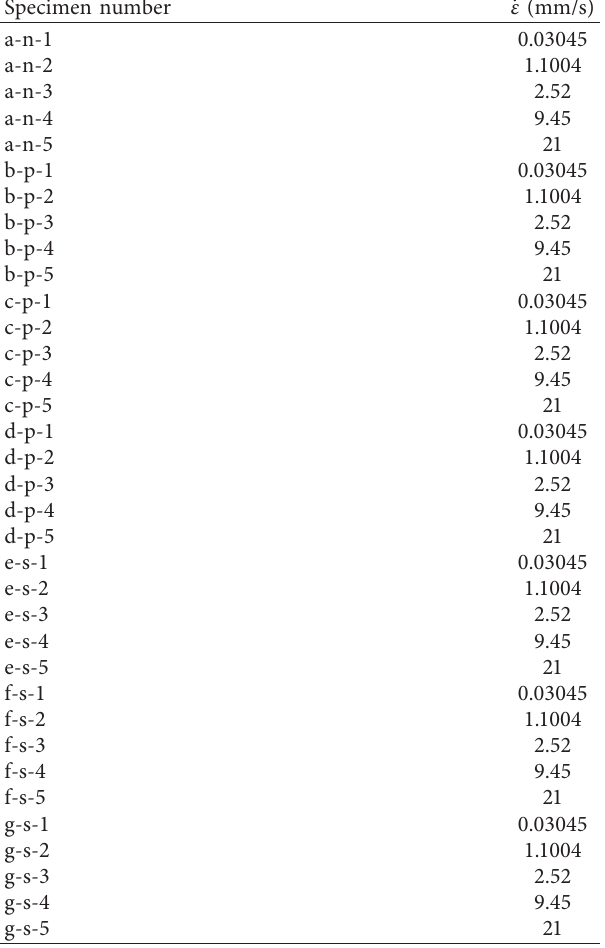
Table 2: Test conditions of cylindrical specimens. Specimen